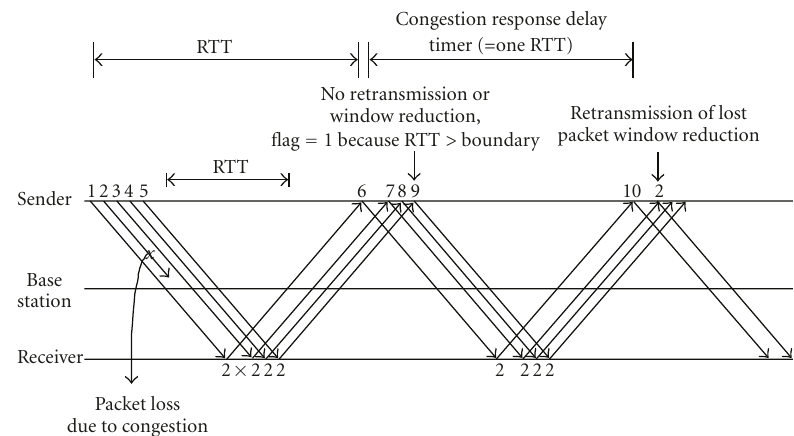
Figure 7: Behavior of the proposed scheme II: a congestion